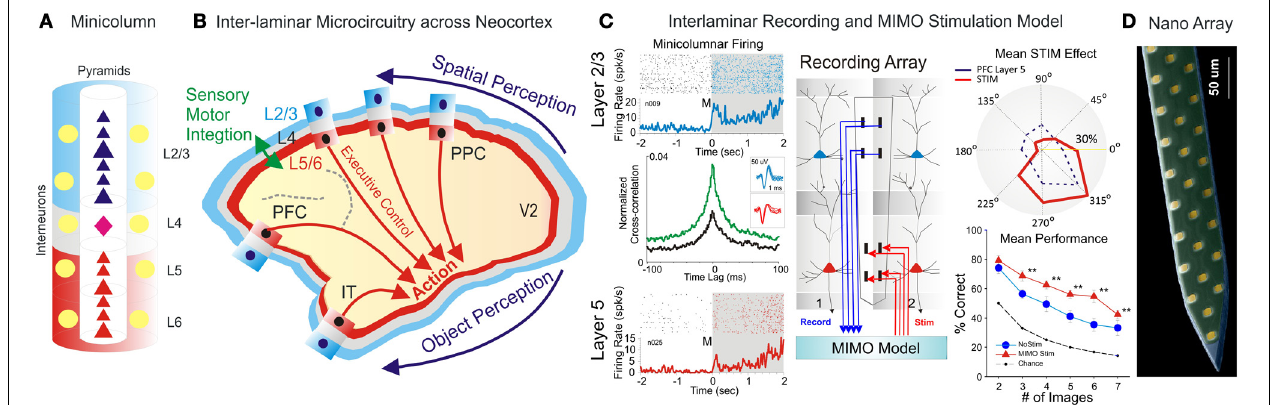
FIGURE 1 | Inter-Laminar Microcircuits across the Neocortex. (A) Cortical minicolumn with pyramidal cells labeled in dark blue for supra-granular layers and red for infra-granular layers. Stellate cells in layer 4 are colored in pink. The “curtain of inhibition” is depicted by interneurons, colored in yellow. (B) Primate brain showing the cortical mantle split in cortical layers and minicolumns. Minicolumn across neocortex work cooperatively to translate perception into complex action. (C) Interlaminar recording of pyramidal cells and MIMO stimulation model. Rasters and peri-event histograms in blue and red depict the activity of supra-and infra-granular